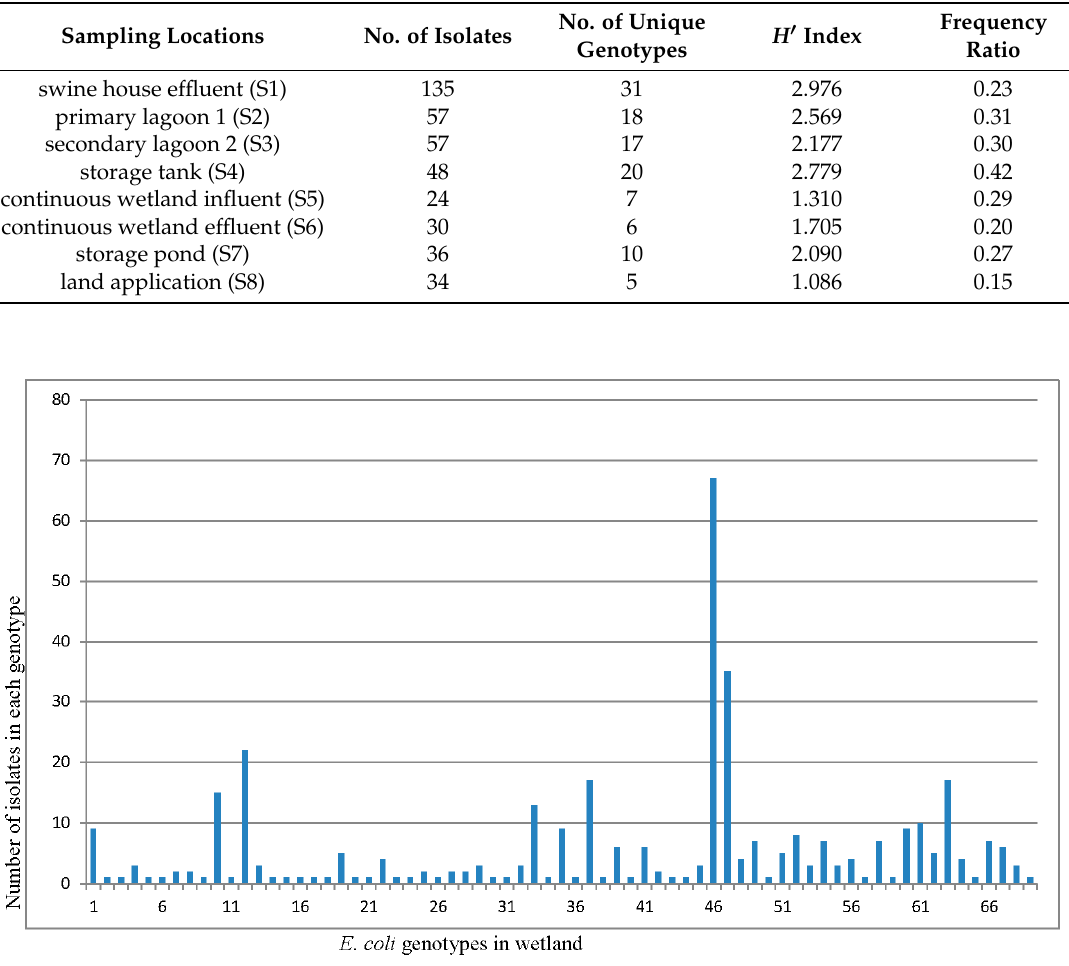
Figure 4. E. coli isolates (421) from swine wetland were analyzed by REP-PCR DNA fingerprint and then grouped into 69 unique genotypes based on cluster analysis. The distribution of genotypes among the sampling sites and their detection frequencies, i.e., number of isolates per genotype at different sites.